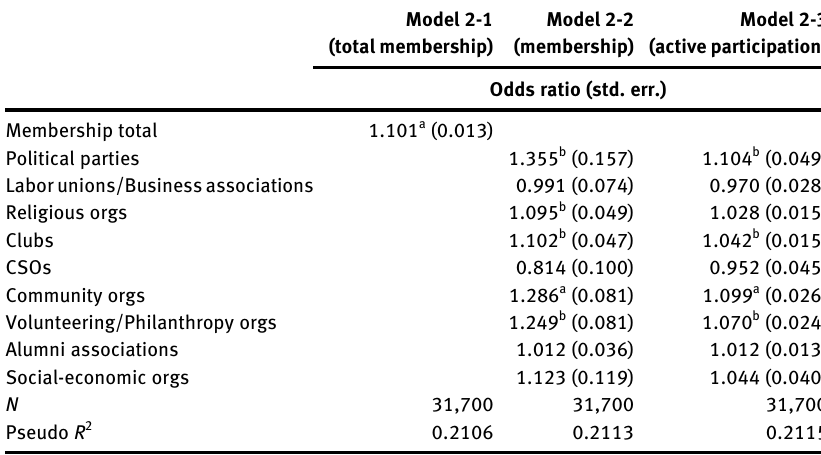
Table  : Logistic regression analysis results: voting and membership and participation in voluntary